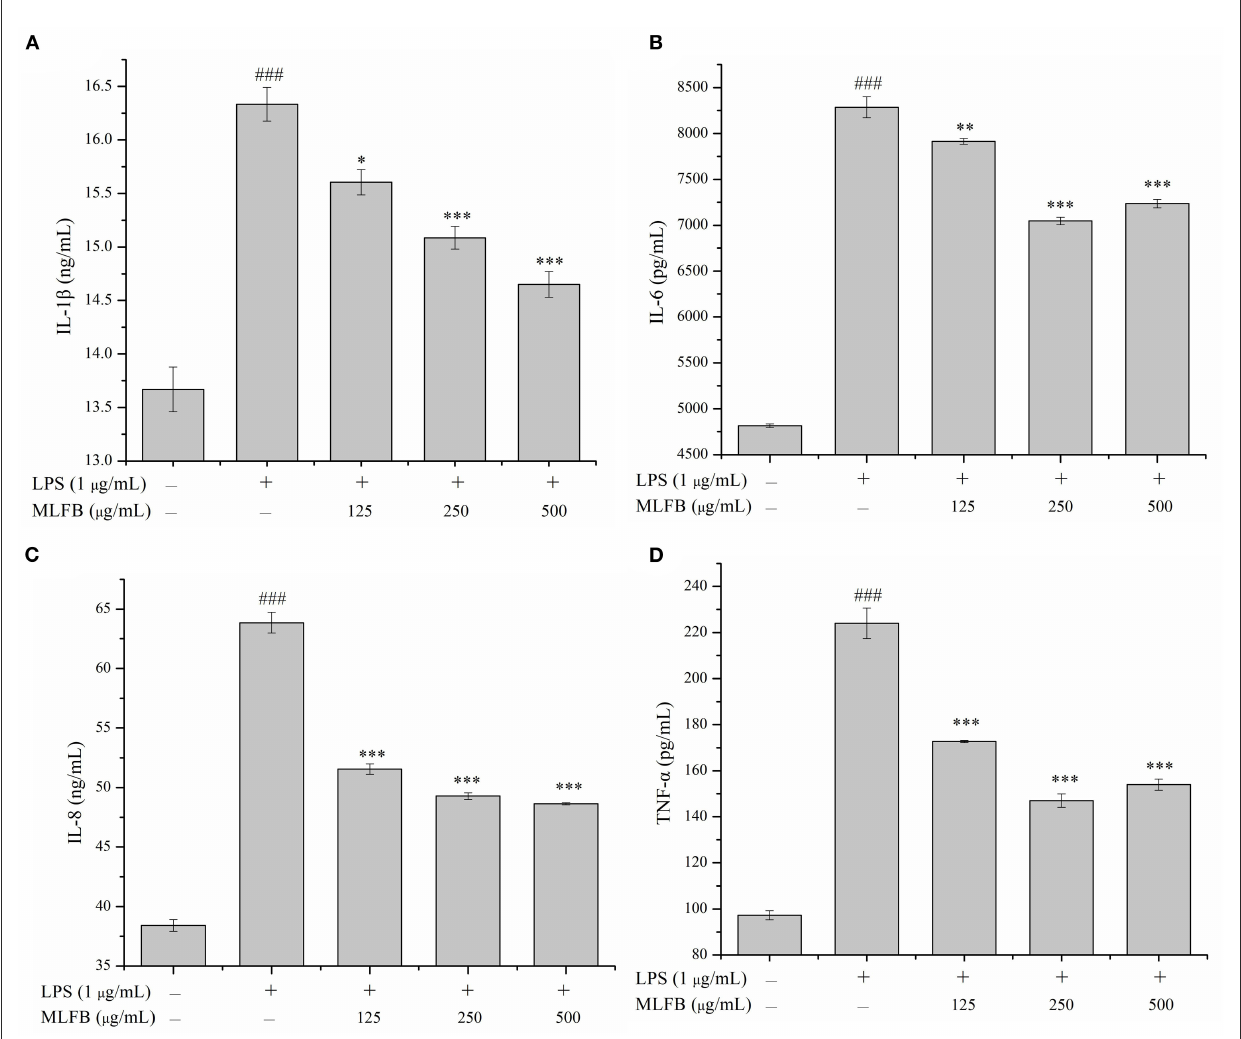
FIGURE2 Effects of MLFB on the secretions of IL-1 β (A) , IL-6 (B) , IL-8 (C) , and TNF- α (D) in LPS-induced RAW 264.7 cells. # Means statistical difference compared with blank control group ( ### P < 0.001). *Means statistical difference compared with LPS-induced inflammatory model group (* P < 0.05, ** P < 0.01, *** P <